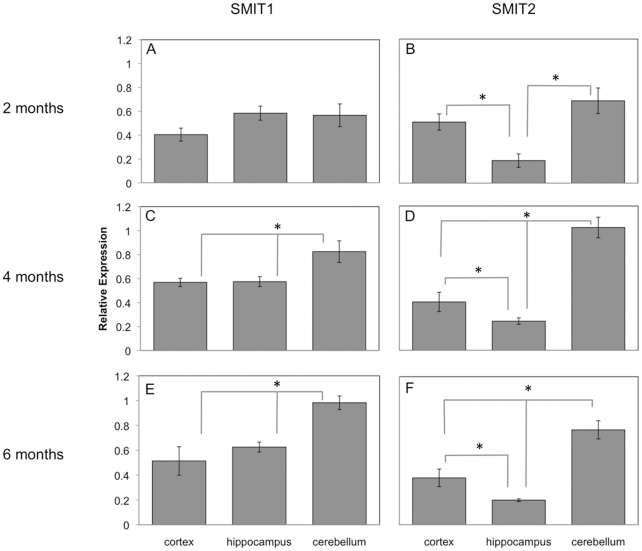
A comparison of regional expression for each of the inositol transporters.A comparison of the regional expression patterns of SMIT1 (A, C, E) and SMIT2 (B, D, F) in the brain at 2 months (A, B), 4 months (C, D) and 6 months of age (E, F) showed a distinct pattern of expression. SMIT1 levels were significantly higher in the cerebellum than in the cortex or hippocampus at 4 and 6 months of age. SMIT2 levels were significantly higher in the cortex and cerebellum, compared to the hippocampus at all three time points and significantly higher in the cerebellum, compared to the cortex, at 4 and 6 months of age. (n = 10 animals/group; p<0.05).